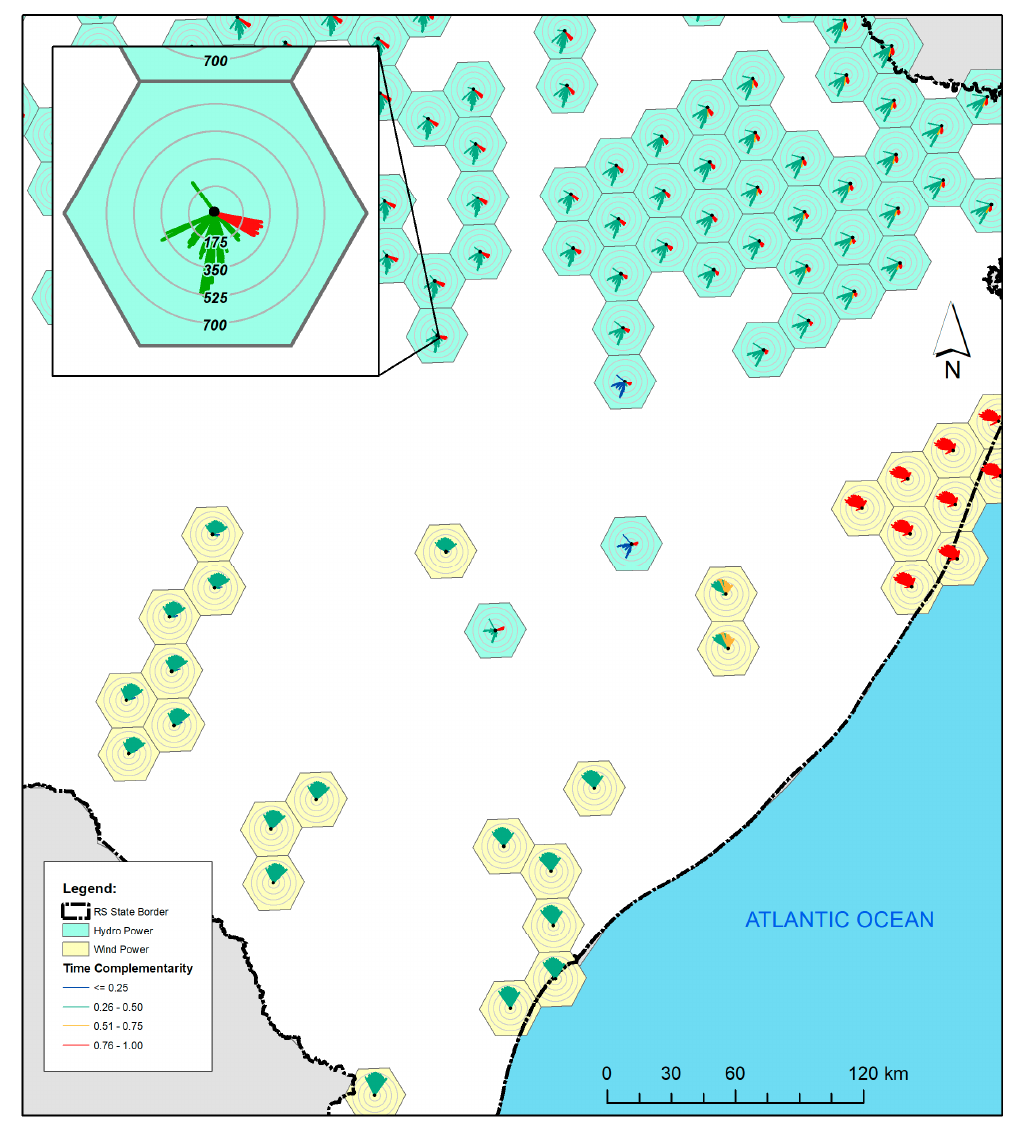
Figure 9. Detail of the eastern center region of the map shown in Figure 8.